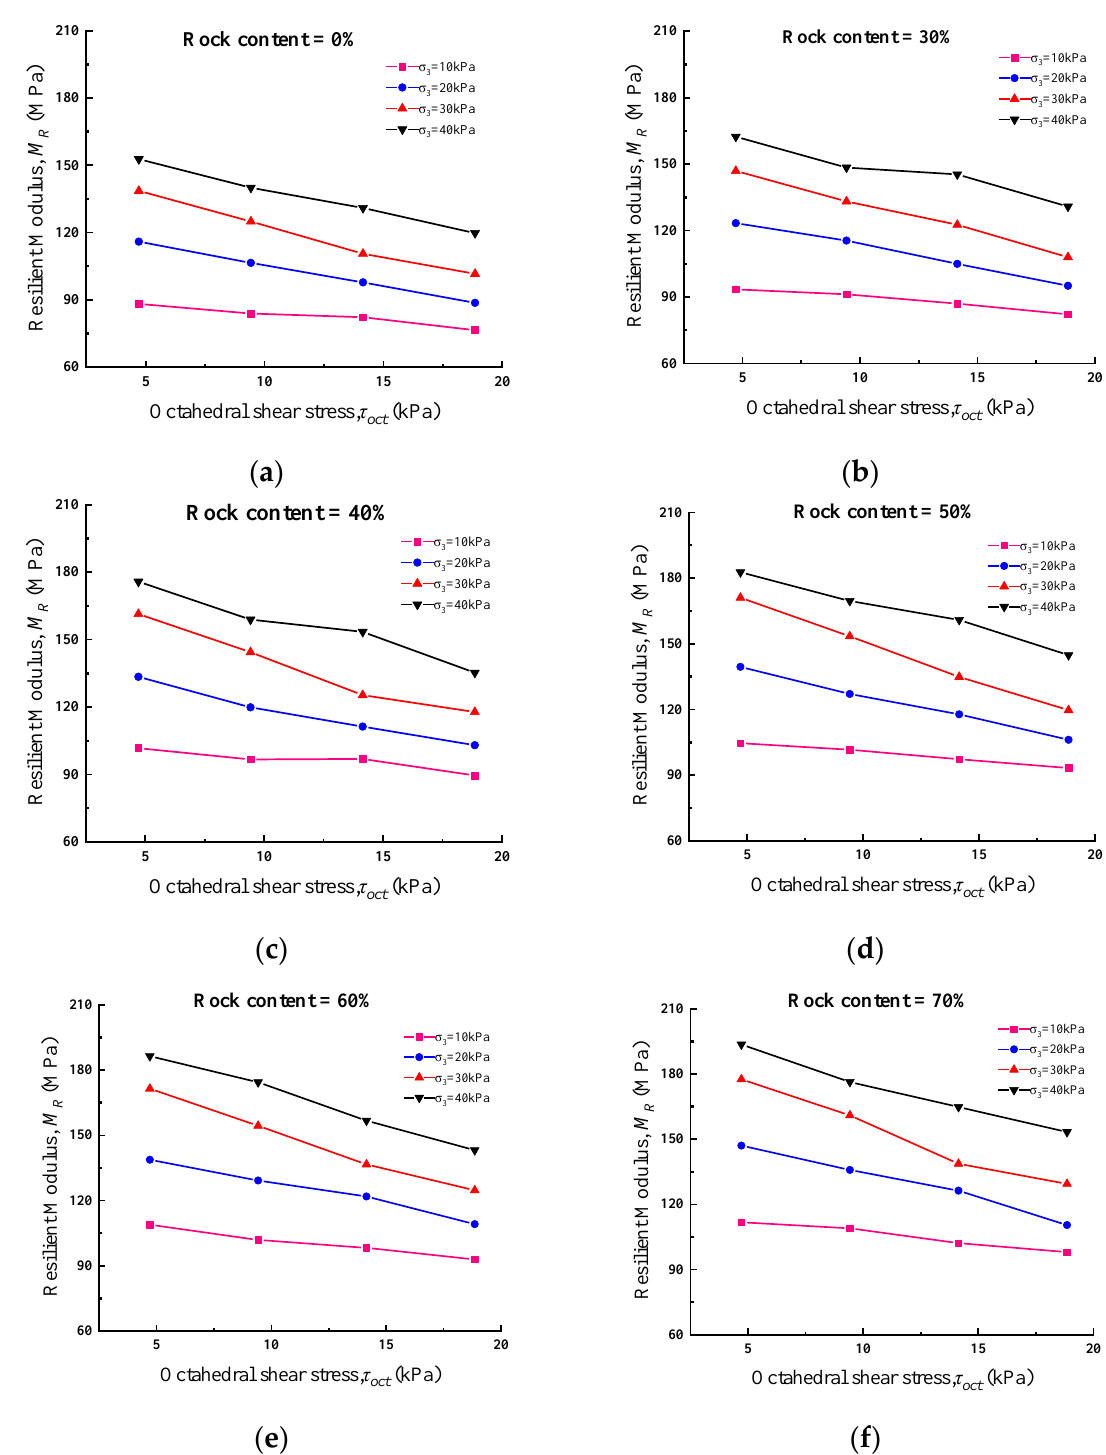
Figure 1. Relationship between SRM resilient modulus and octahedral shear stress (Compaction = 96%) with different R c : ( a ) 0%; ( b ) 30%; ( c ) 40%; ( d ) 50%; ( e ) 60%; ( f ) 70%.